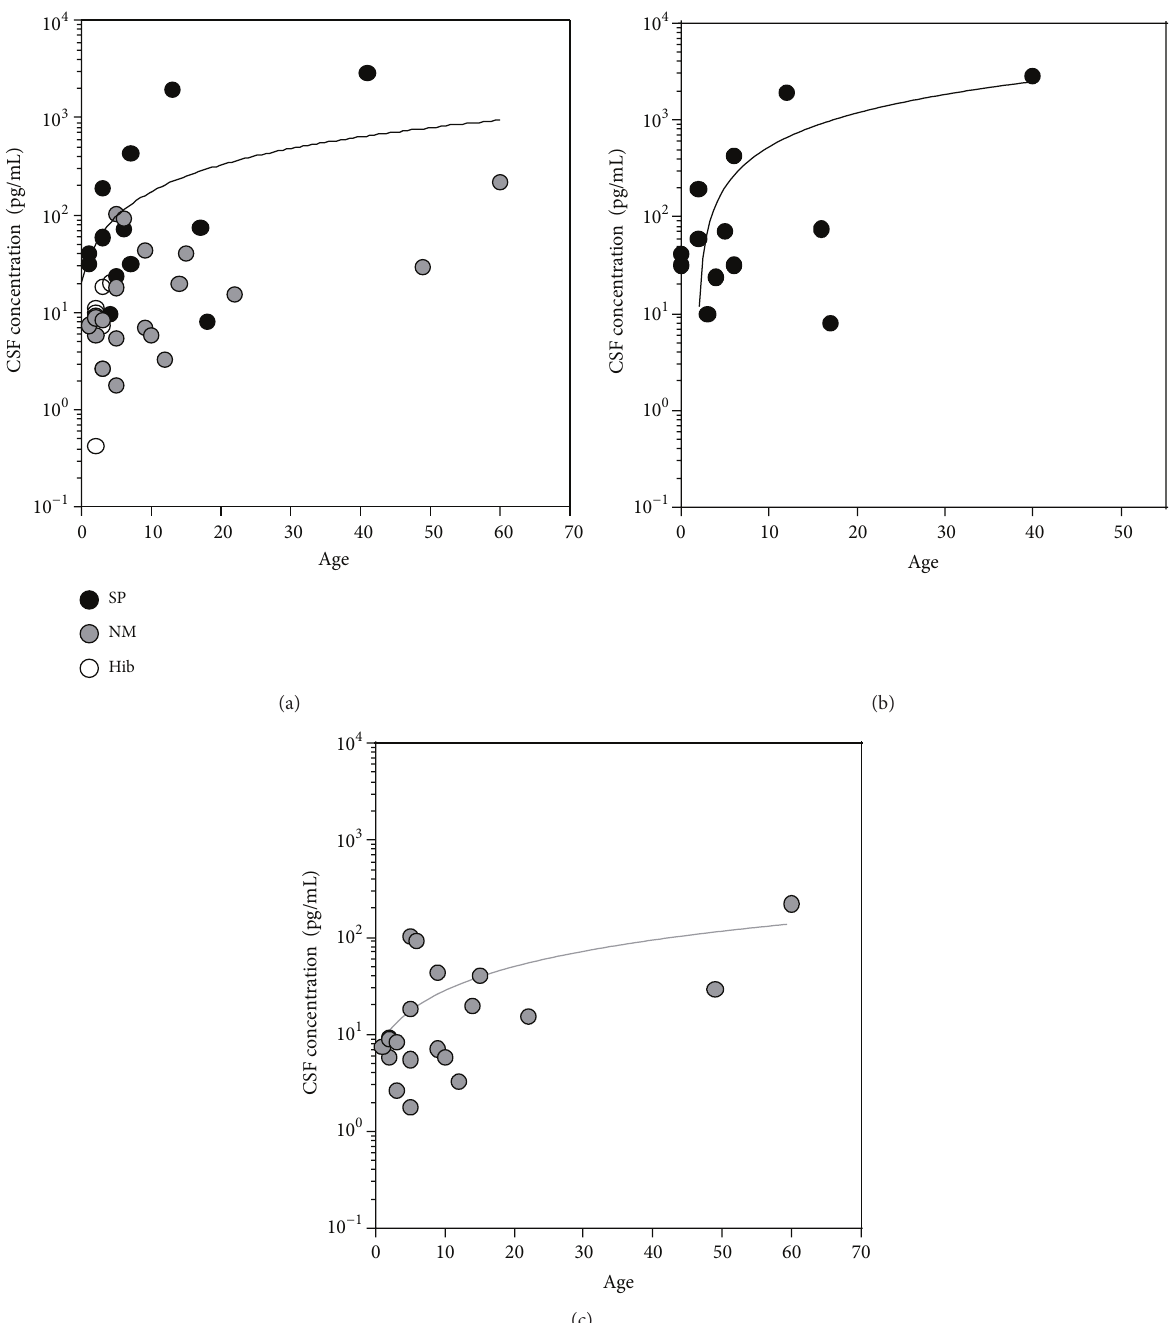
Figure 2: Correlation between CSF levels of IFN- 𝛾 and age of the patients. (a) The level of IFN- 𝛾 correlated with the age of the patients. This correlation was significant for SP patients ((b): 𝑃 = 0.01, 𝑟 = 0.79 , and black dots) and NM patients ((c): 𝑃 = 0.02, 𝑟 = 0.64 , and grey